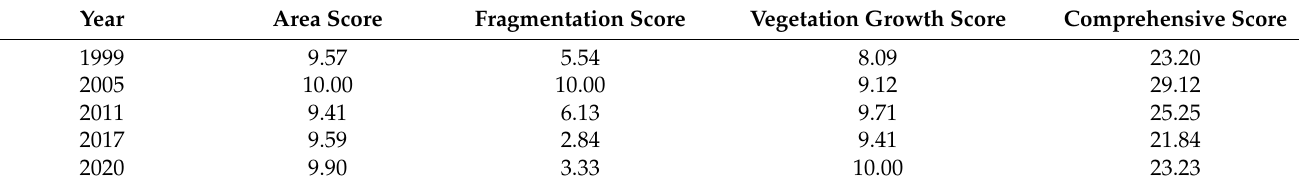
Table 4. Bird habitat rating table in reed wetlands from 1999 to